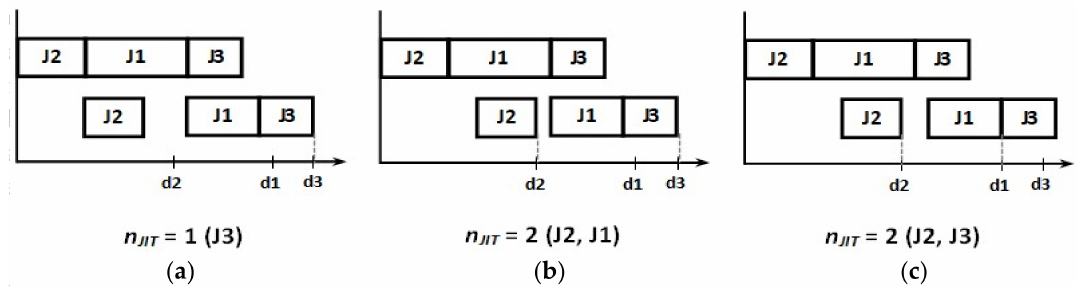
Figure 1. Example of different schedules with the same sequence of jobs: ( a ) only J 3 is just-in-time; ( b ) J 2 and J 1 are just-in-time; and ( c ) J 2 and J 3 are just-in-time.